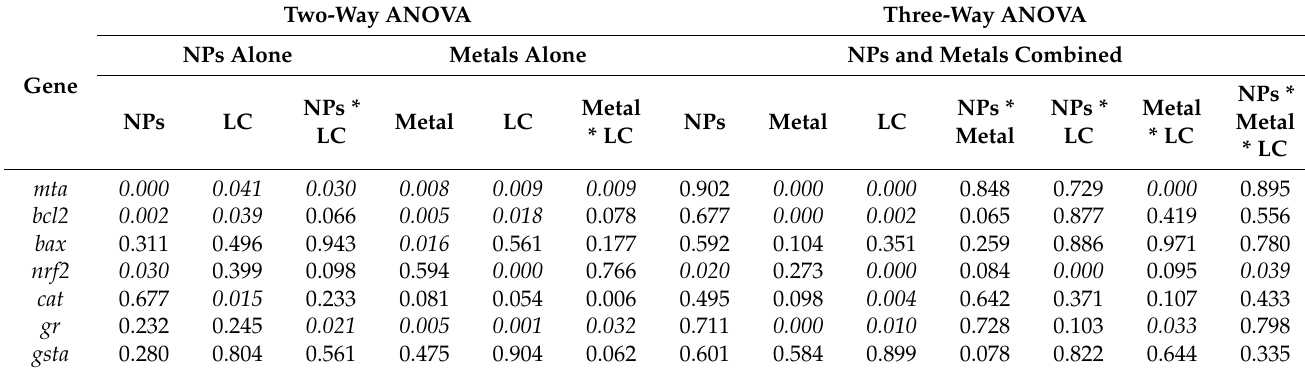
Table 2. Summary of ANOVA results of the transcription of genes in SaB-1 cells upon 24 h exposure to 1 µ g mL − 1